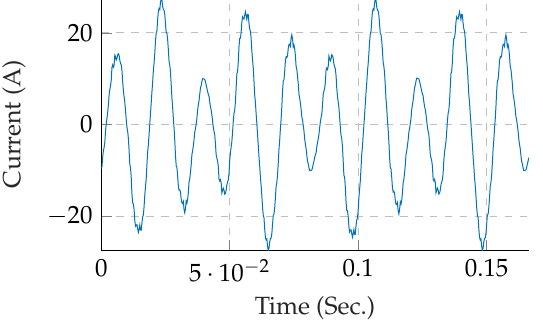
Figure 5. Stator phase current in 20% slip operation with sinusoidal supply voltage. The additional major frequency component along with the fundamental is ( 1 − 2 s ) ω